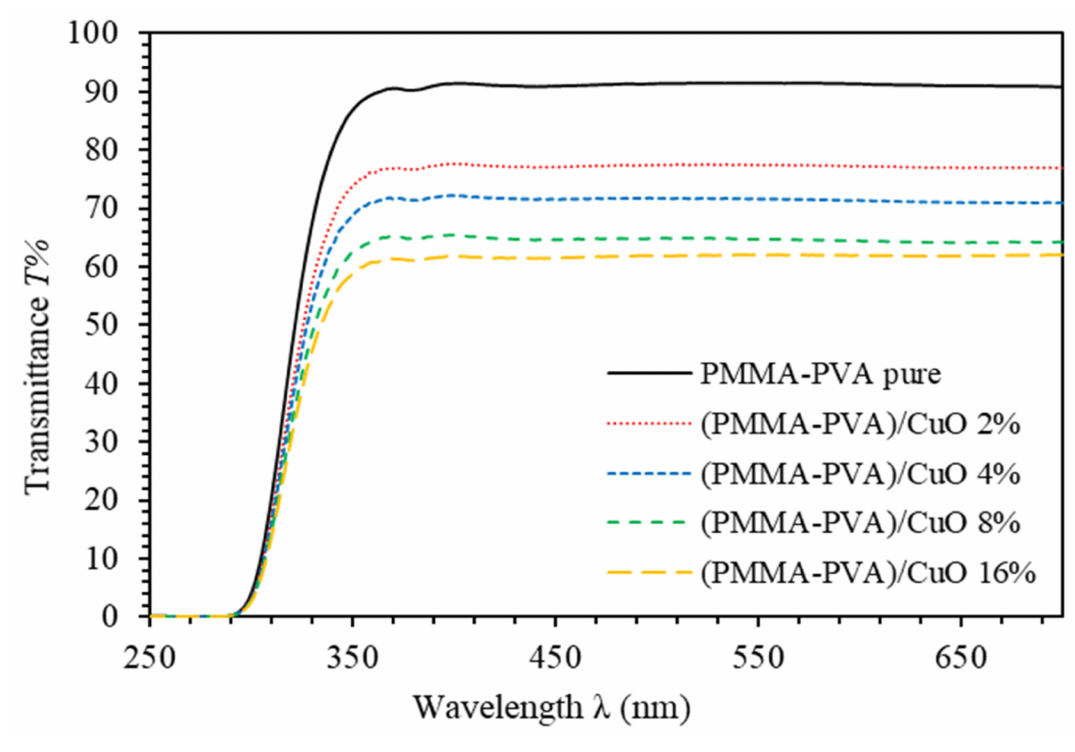
Figure 1. Transmittance spectra of PMMA–PVA/CuO nanocomposite thin films as a function of wavelength containing different CuO NPs concentrations.